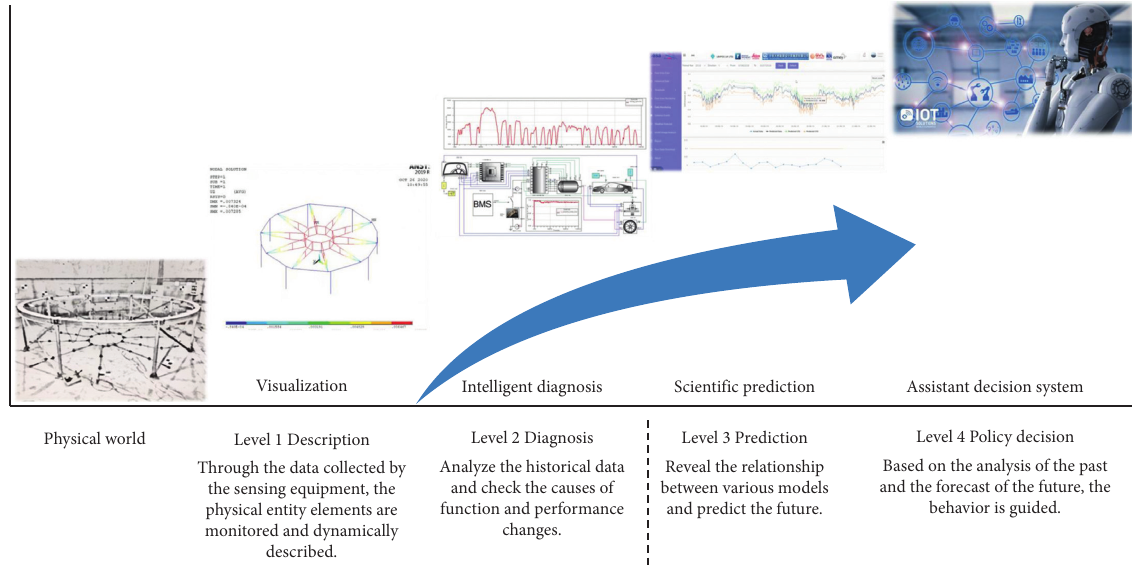
Figure 1: Hierarchical structure of digital twin in the structure operation and maintenance